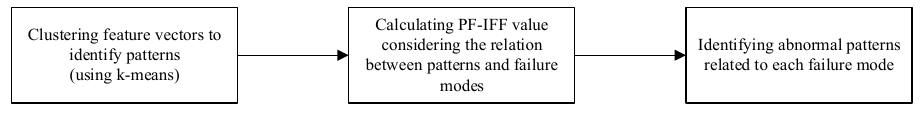
Figure 3. Process for identifying abnormal patterns.